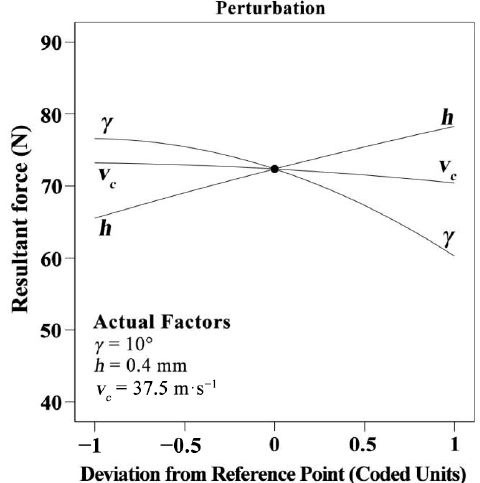
Figure 4. Effect of cutting conditions on resultant force.